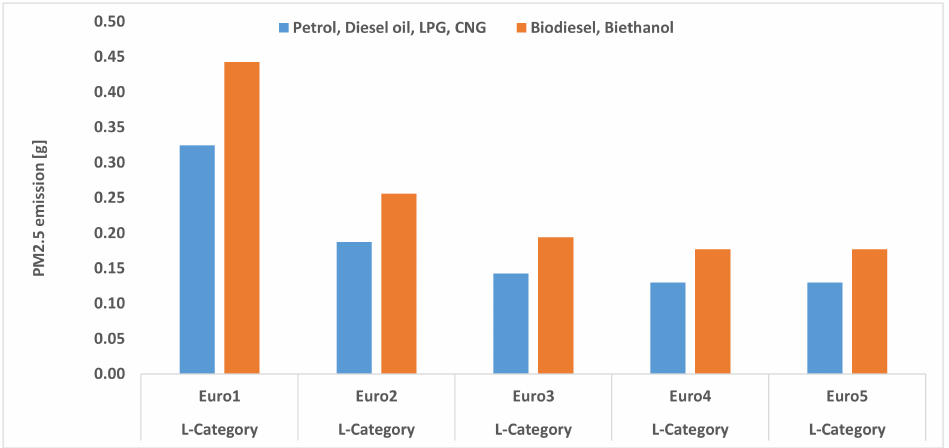
Figure 15. Comparison of PM2.5 emissions from L-category vehicles depending on Euro standard and fuel